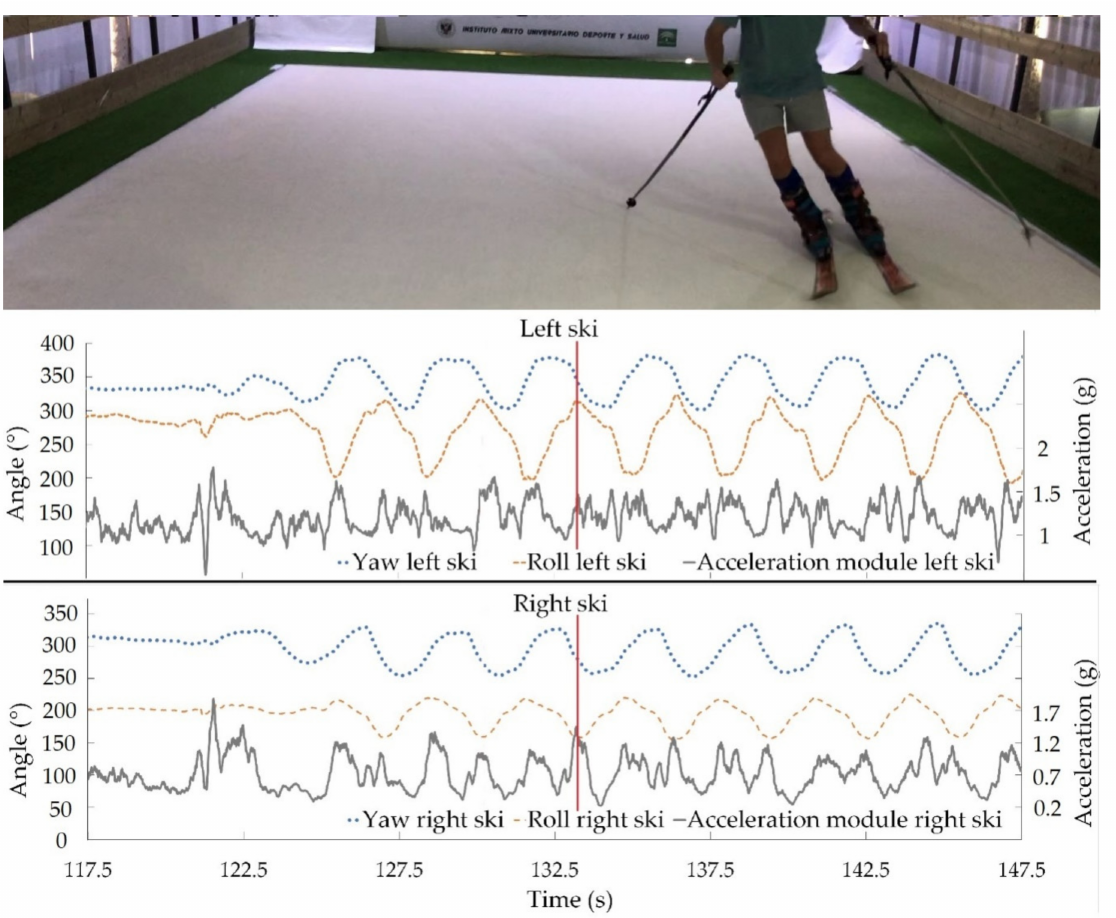
Figure 6. Synchronized yaw, roll, and acceleration modulus in the xy plane for each ski around the beginning of a turn. Vertical line shows the point of maximum xy acceleration of turns by participant